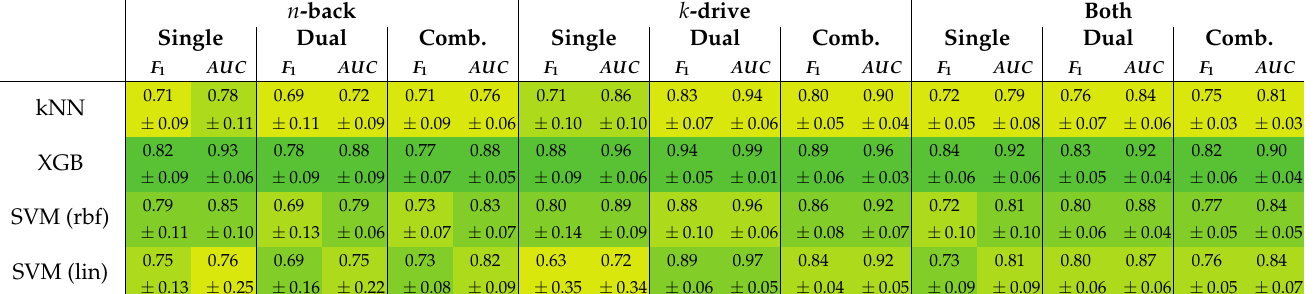
Table 10. Comparison of different classifiers for all binary tasks. All classifiers have been trained using the complete set of features: bio-signals, eye-tracker data and action units from videos. The results in this table correspond to the last row in Table 8 for XGBoost based classification. kNN is a k-Nearest-Neighbor classifier, SVM (rbf) a support vector machine with a radial kernel and SVM (lin) is a linear support vector machine. All results have been acquired using nested-cross-validation. k -drive